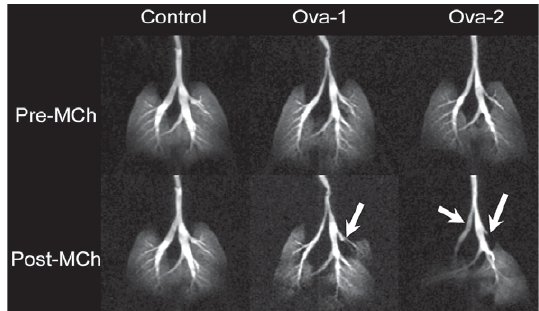
Fig. 18. Gas exchange in the mouse lungs of models of asthma (Ova sensitized) compared to a control animal. Maximum intensity pro- jections based on 3D (radial acquisition) images of 3 He distribution in the lungs before and after administration of 250 (cid:1) g/kg metha- choline (MCh) challenge. The image were aquired using TR=5ms, TE=132 (cid:1) s, bandwidth (BW)=62.5kHz, with 20 radial k-space views per breath, interpolated to 256 × 256 × 16 matrix and reso- lution is 125 × 125 × 1000 (cid:1) m 3 . Airways constriction is indicated with white arrows in the Ova-sensitized mice. Reproduced with per- mission from [26].